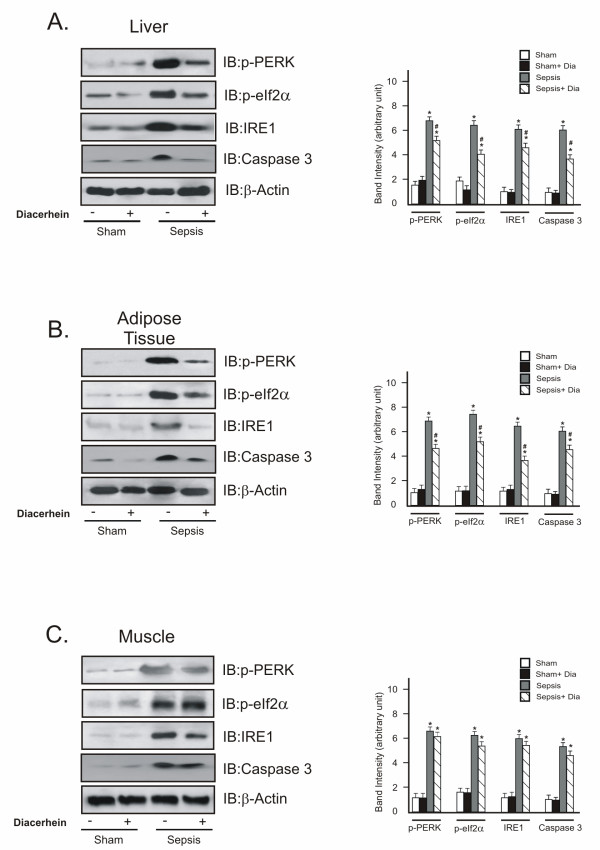
Effects of diacerhein treatment on proteins that reflect ER stress in the CLP rat. Representative blots show the PERK, eIF2α phosphorylation, and IRE-1 expression in liver (A), adipose tissue (B), and muscle (C) of sham and septic rats. Blots were stripped and reprobed with β-actin (lower panels) to confirm equal loading of proteins. Data are presented as mean ± SEM from six to eight rats per group. *P < 0.05 versus Sham/Vehicle; #P < 0.05 (Sepsis/Veh versus Sepsis/Dia). IB, immunoblot; Sham, Sham/Vehicle; Sham+Dia, Sham/Diacerhein; Sepsis, Sepsis/Vehicle; Sepsis+Dia, Sepsis/Diacerhein.